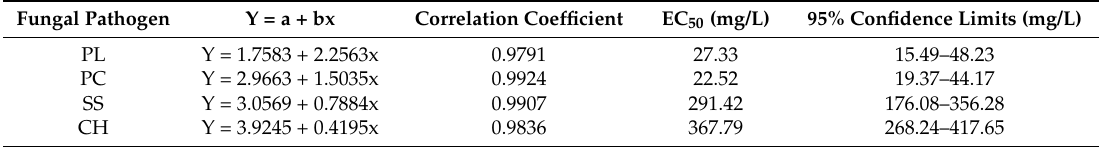
Table 2. Effect of isoliquiritin on four plant pathogenic fungi toxicity measurement results.